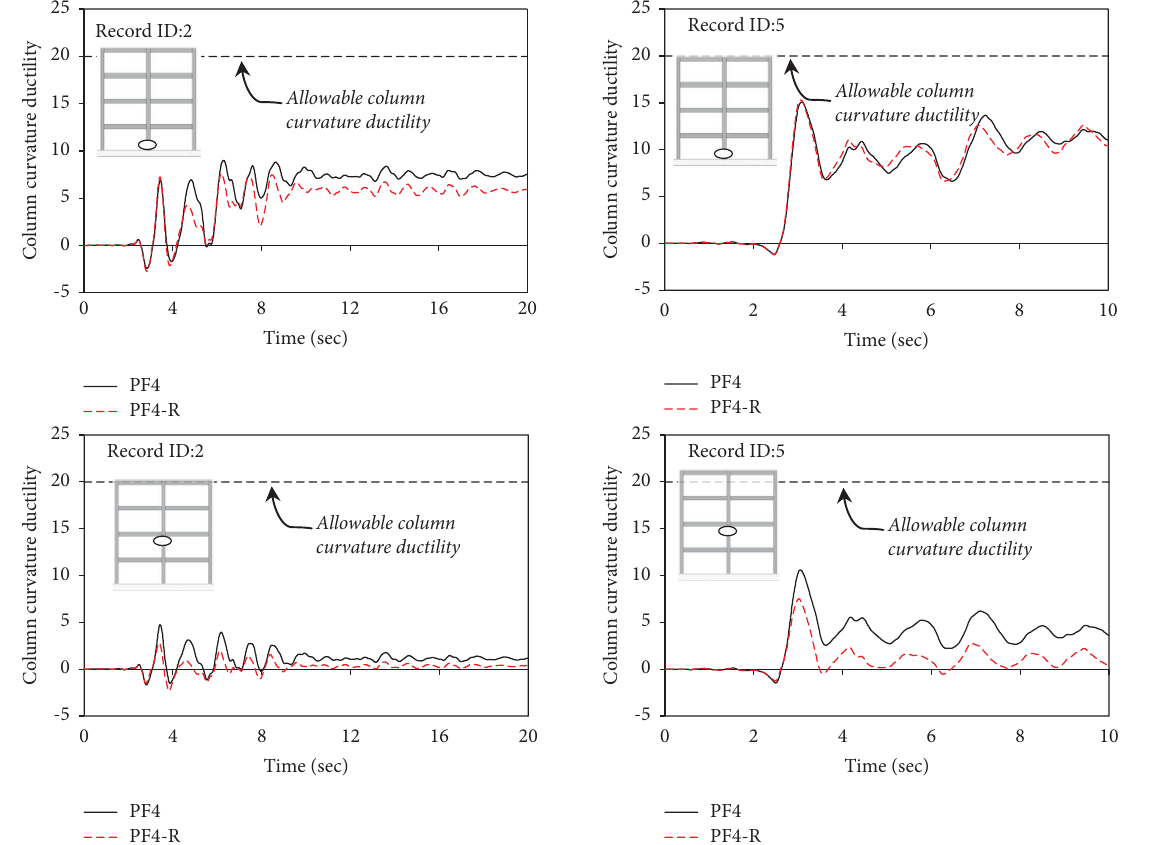
Figure 18: Time histories of curvature ductility demand placed upon the columns of the four-story frames subjected to Kobe and Northridge earthquake ground